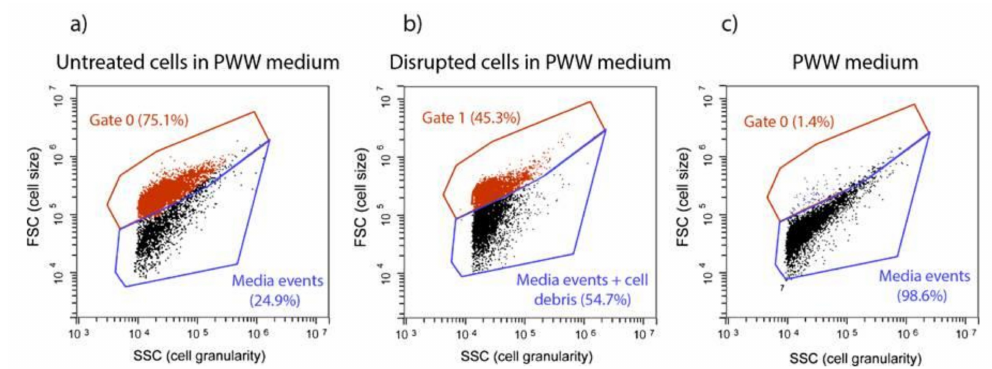
Figure 1. Flow cytometry populations gates present in ( a ) untreated cells in PWW media, ( b ) disrupted cells in PWW media using FSC/SSC dot plots, ( c ) piggery wastewater (PWW)